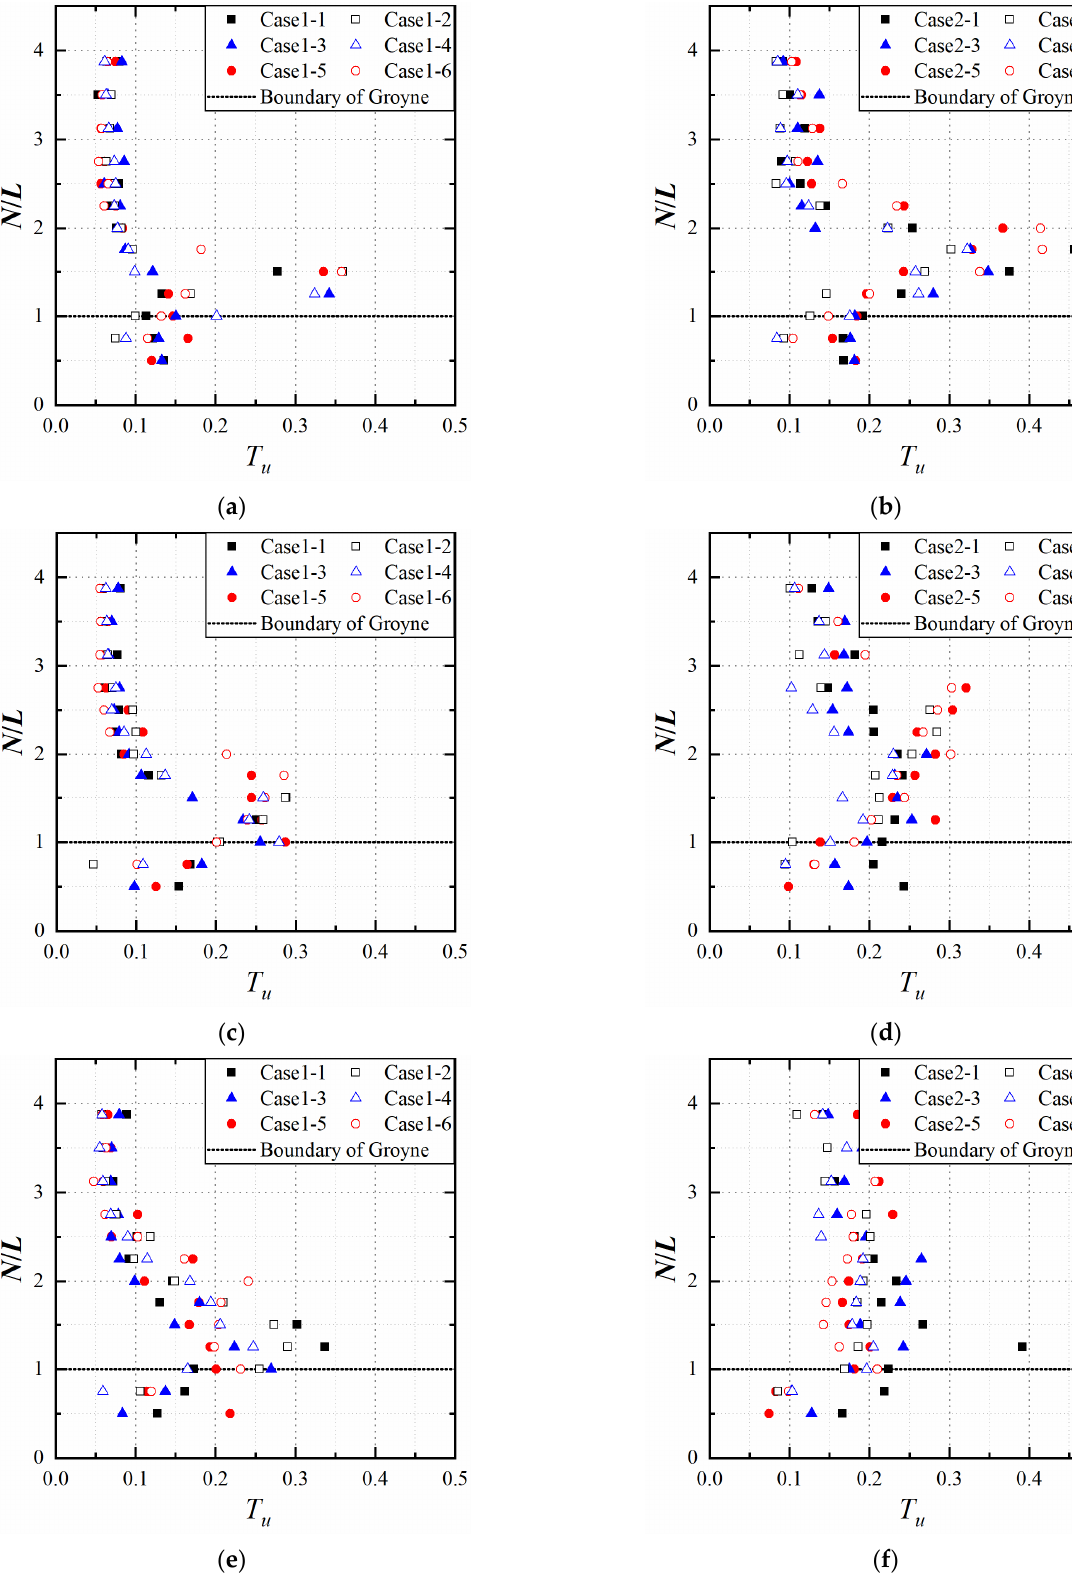
Figure 5. Longitudinal turbulence intensity distribution of typical cross section: ( a ) Section CS06 (fixed bed), ( b ) Section CS06 (mobile bed), ( c ) Section CS10 (fixed bed), ( d ) Section CS10 (mobile bed), ( e ) Section CS14 (fixed bed) and ( f ) Section CS14 (mobile bed).